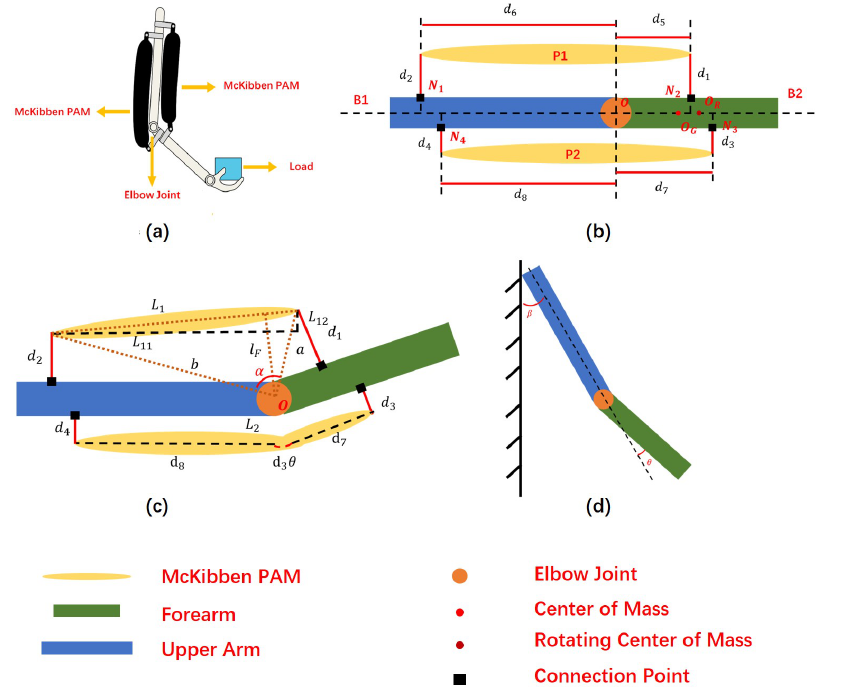
Figure 2. Mechanical system design: ( a ) structure; ( b ) schematic diagram with initial phase; ( c ) schematic diagram with rotation phase; ( d ) rotation angle θ and inclination angle β